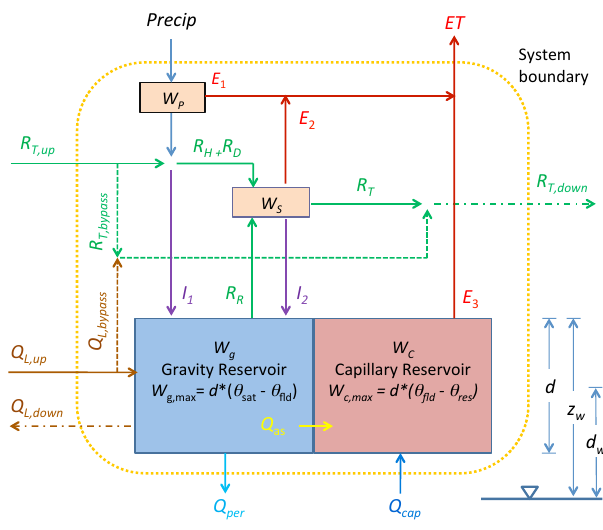
Figure 1. Schematic diagram of MOBIDIC’s mass balance at each soil